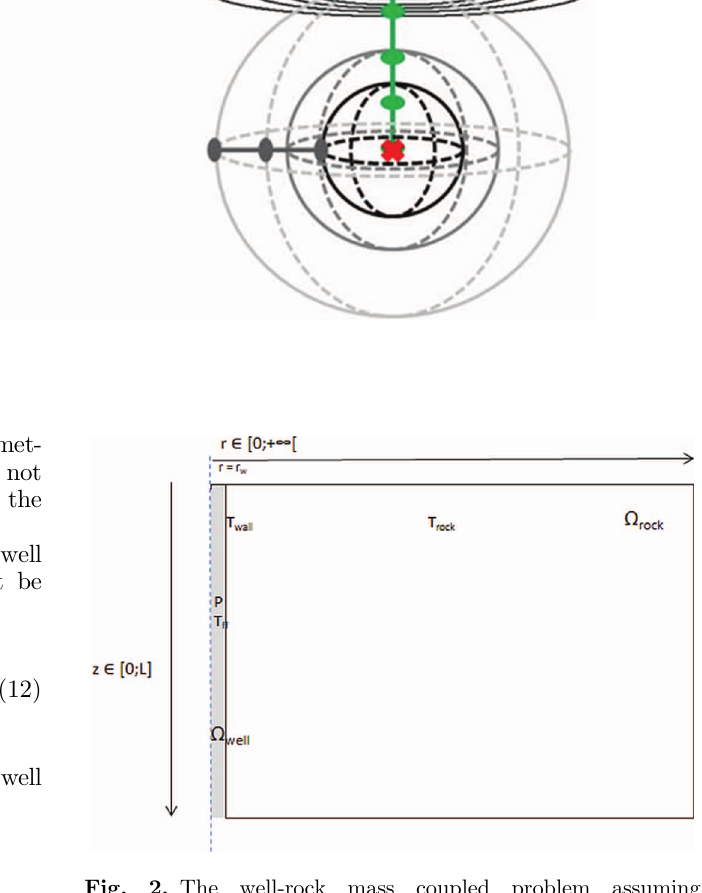
Fig. 2. The well-rock mass coupled problem assuming axisymmetry.